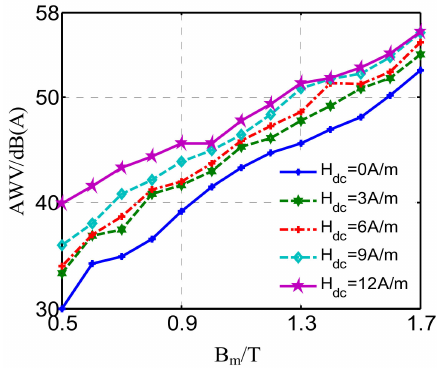
Figure 7. A-weighted noise value under di ff erent DC-biased magnetizations.